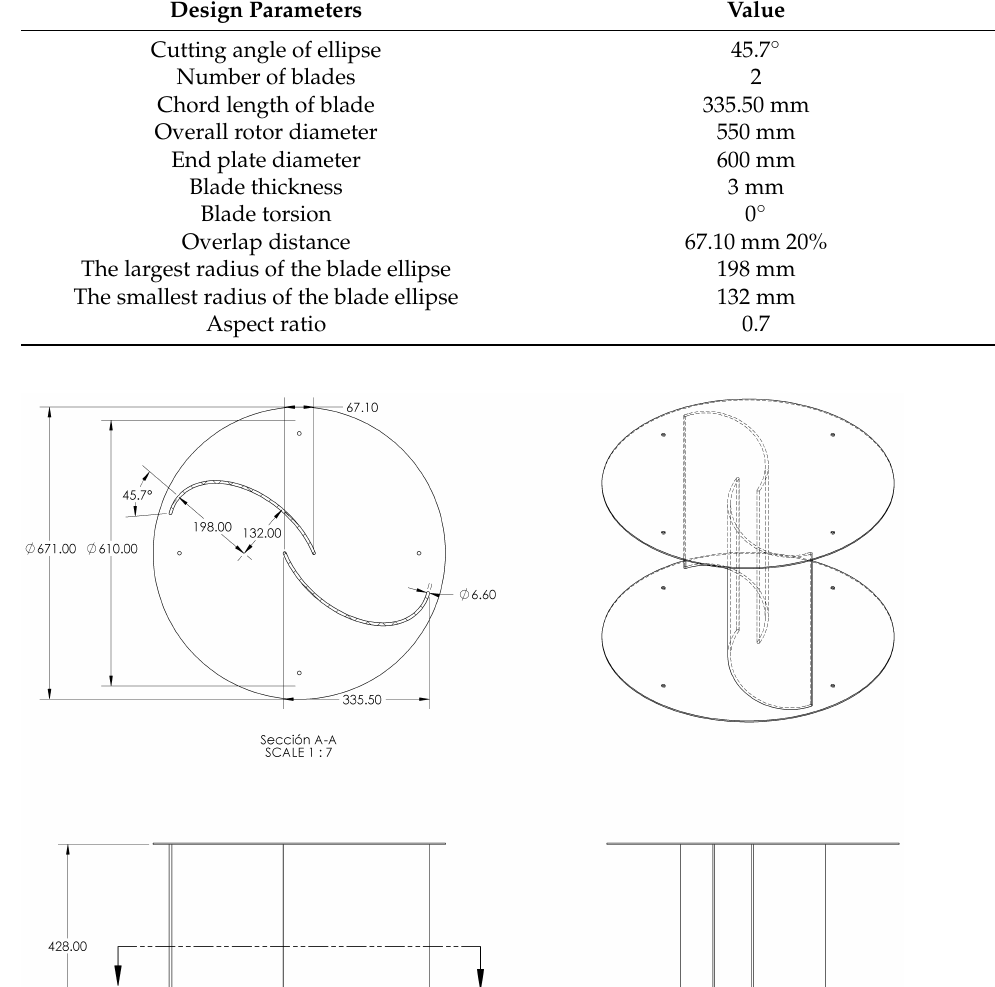
Table 1. Parameters of the selected Savonius.